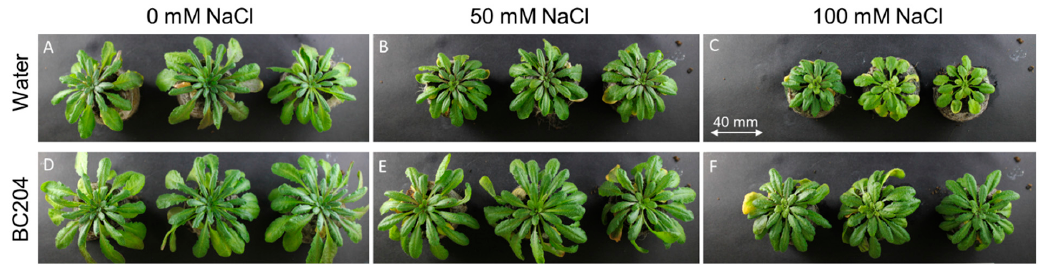
Figure 1. Rosette growth of Arabidopsis thaliana plants in response to salt (NaCl) and BC204 treatments. Plants were treated with water ( A ), 50 mM NaCl ( B ), 100 mM NaCl ( C ), 0.01% ( v / v ) BC204 ( D ) and combinations of BC204 and 50 mM ( E ) and 100 mM ( F ) NaCl.